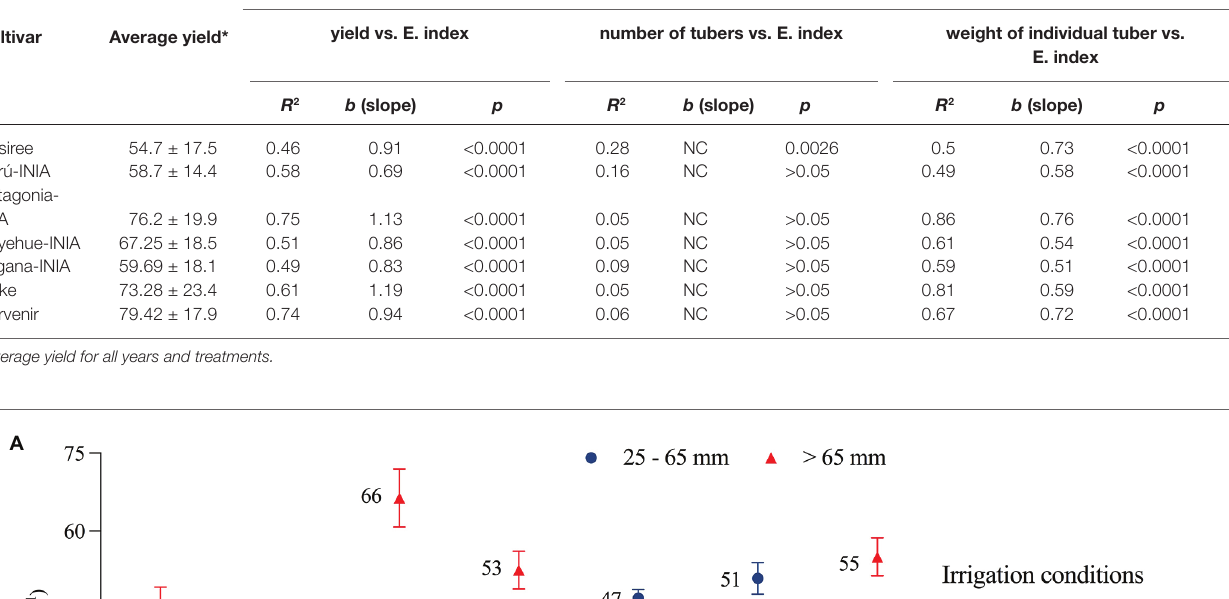
TABLE 5 | Coefficients of the regression between yield and environmental index for seven potato varieties. Regression parameters in function of the environmental index (E. index) yield vs. E. index number of tubers vs. E. index weight of individual tuber vs. Cultivar Average yield*